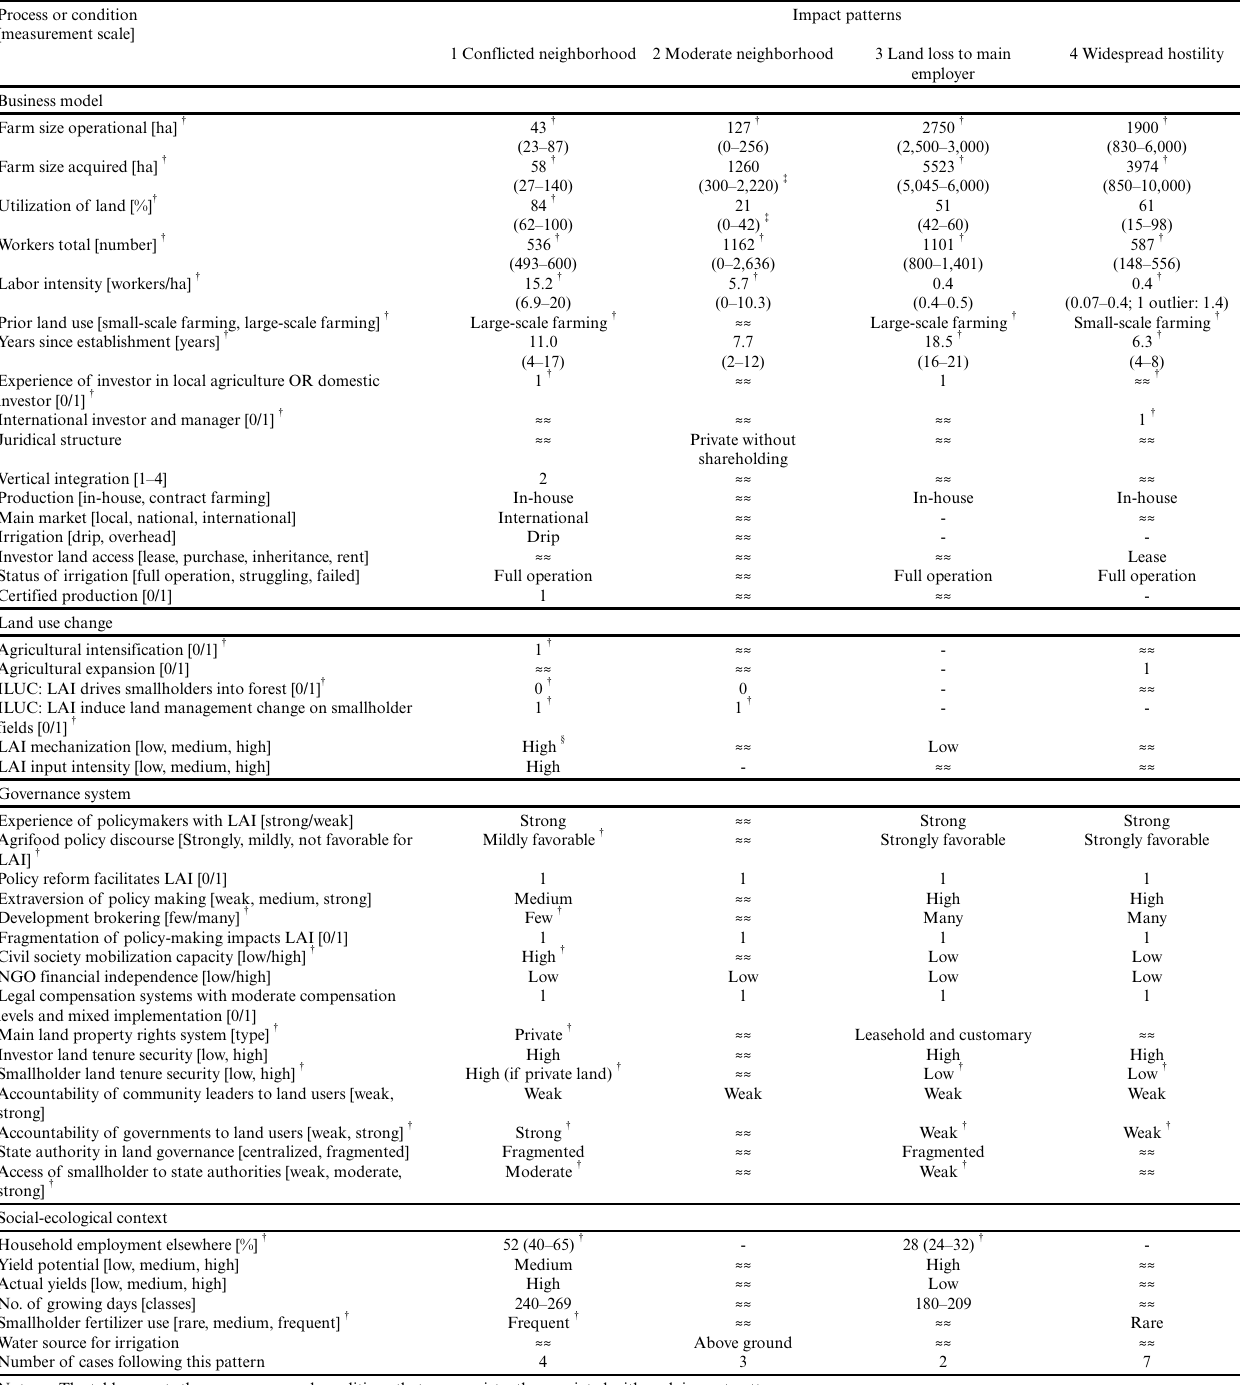
Table 2. Processes and conditions of land use changes, business models, governance, and social-ecological contexts associated with each impact